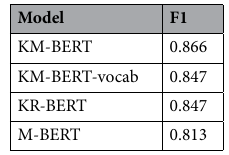
Table 5. Extrinsic evaluation results on Korean medical